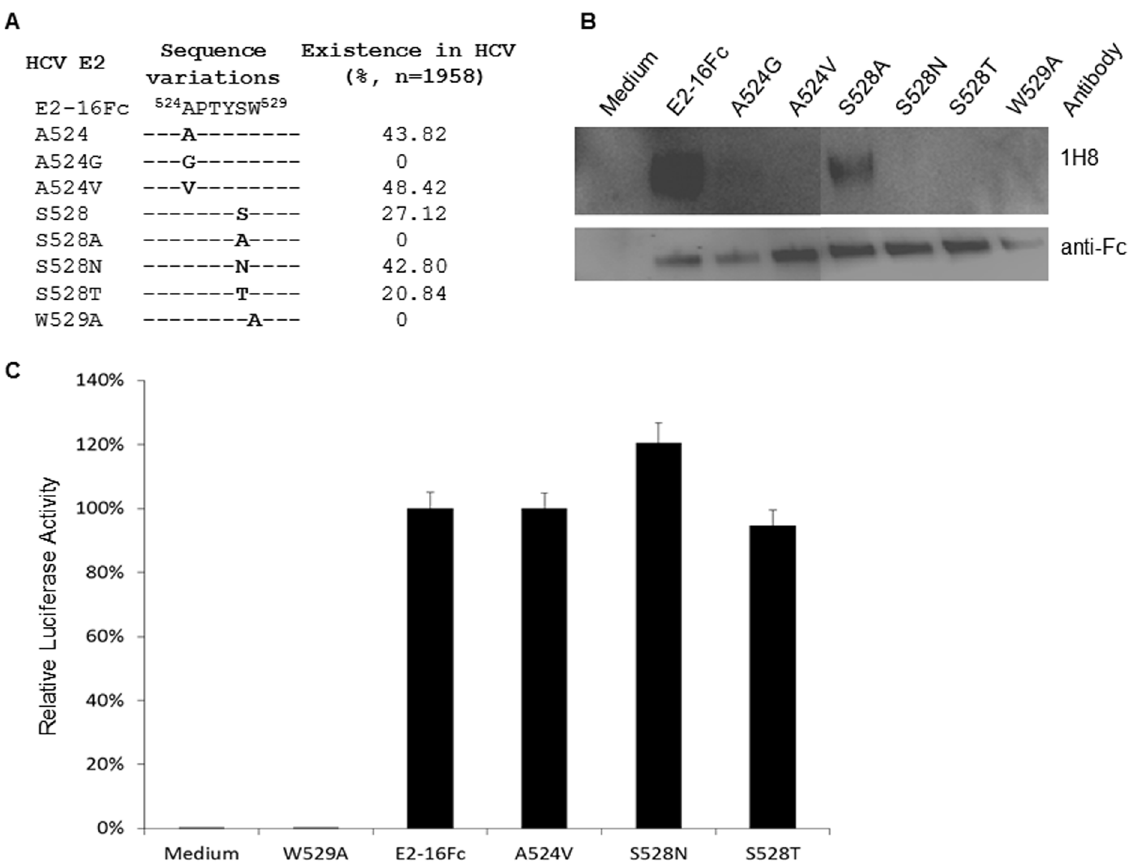
Figure 6. Effect of naturally occurring variants of the E2 protein with specific residue substitutions in the linear epitope on the 1H8 binding and the CD81 interaction. (A) The residues 524–529 derived from the E2 protein of H77 strain, i.e., E2-16Fc, is indicated, which serves as a reference sequence. The bold letter shows the presence of a specific residue at that position. The hyphen indicates any possible amino acids at these positions although the residues at positions of 525, 526,527 and 529 are highly conserved among the strains (Table 1). The prevalence of the strains containing a specific residue (bold letter) in the ViPR database is shown. (B) The reactivity of 1H8 to the E2 protein with an indicated substitution was determined in a Western blot analysis. The secreted forms of these E2 proteins were produced in Huh7 cells. 1H8 (1:1000 dilution) and an HRP- conjugated anti-mouse IgG (1:3000 dilution) were used as the primary and secondary antibodies, respectively. The detection with anti-Fc (1:3000 dilution) was served as a control. (C) Determination of the interaction between the E2-16Fc variants and CD81-Luc in a luciferase-based binding assay. The x-axis indicates the different constructed E2-16Fc used in the assay. The y axis indicates the relative luciferase activity, representing the direct interaction between E2-16Fc and CD81-Luc.